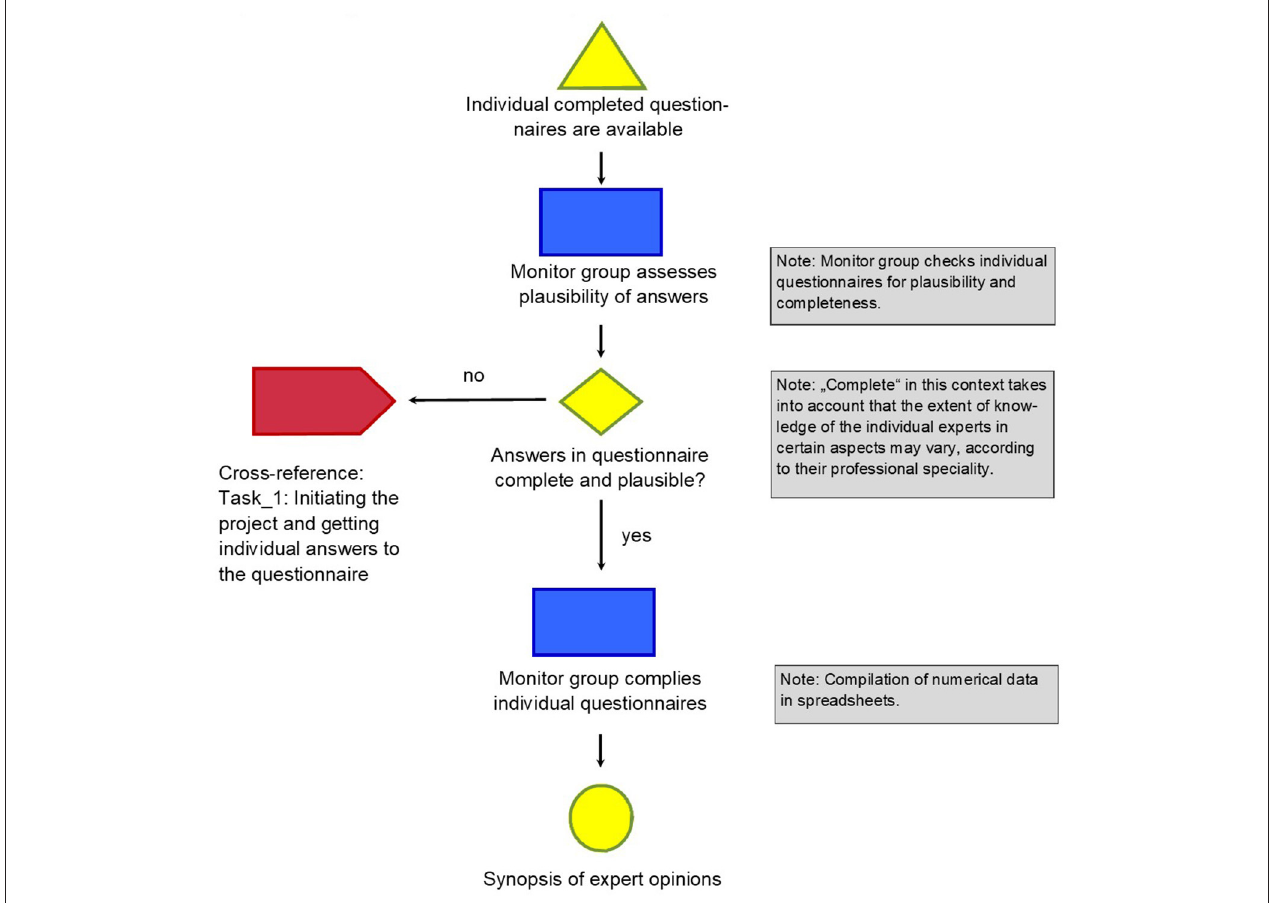
FIGURE 2 | Task_2: Cross-reference: Compilation of questionnaires.